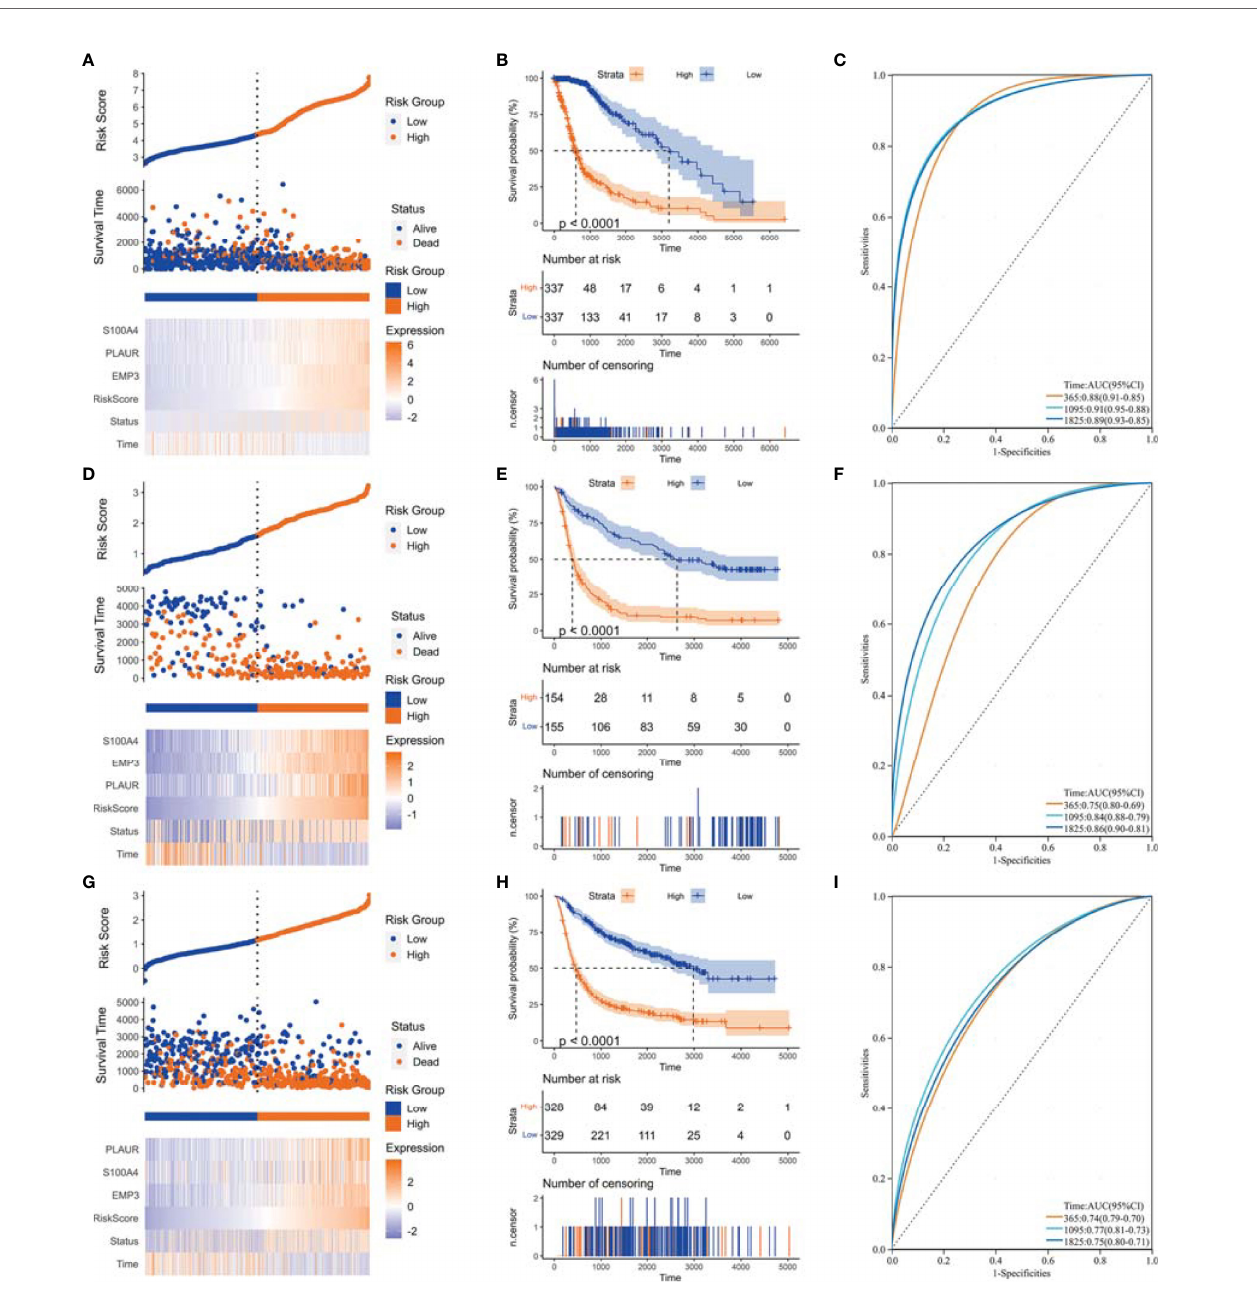
FIGURE 6 | Construction of risk score signature. (A) Distribution of the risk score, survival status, and expression pro fi le of the prognostic genes in the cohort of TCGA GBMLGG cohort, (D) CGGA #325 cohort, and (G) CGGA #693 cohort, respectively. (B) Kaplan – Meier curves displayed prognostic differences between high- and low-risk groups in the cohort of TCGA GBMLGG cohort, (E) CGGA #325 cohort, and (H) CGGA #693 cohort, respectively. (C) The ROC curves described the sensitivity and speci fi city of risk score in predicting OS at 1-, 3-, and 5-year time points in TCGA GBMLGG cohort, (F) CGGA #325 cohort, and (I) CGGA #693 cohort, respectively. ROC, Receiver operating